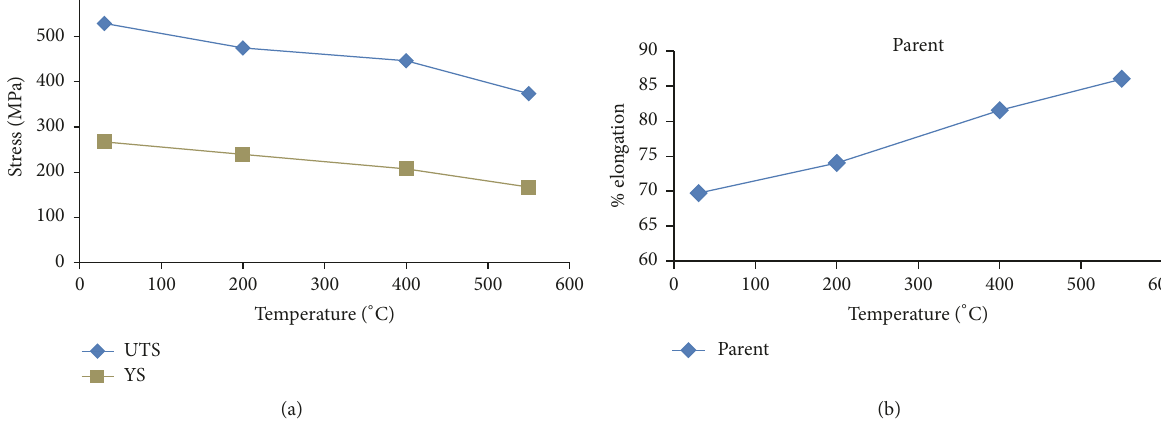
Figure 6: Behaviour of the parent metal at different operating temperature. (a) UTS and YS. (b) % elongation.